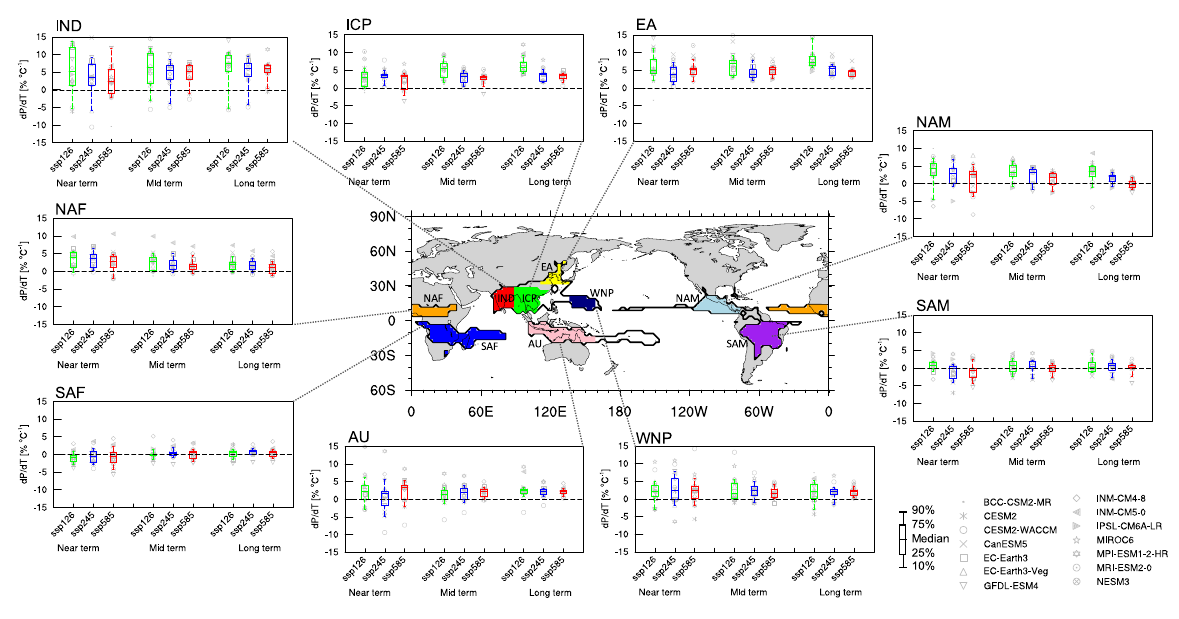
Fig. 2 Percentage changes in precipitation per one-degree Celsius of global warming in CMIP6 future scenarios. The boxplots represent the percentage changes in summertime precipitation per one-degree Celsius (% °C − 1 ) according to the CMIP6 models for three future scenarios relative to near-term, mid-term, and long-term periods over the Northern African (NAF), Southern African (SAF), Indian (IND), Indo- China Peninsula (ICP), East Asian (EA), western-North Paci fi c (WNP), Australian (AU), Northern American (NAM), and Southern American (SAM) monsoon domains. Gray symbols indicate the individual CMIP6 models whereas the boxes indicate the spread (from the 25th to the 75th percentile, with the center lines representing the median) of the CMIP6